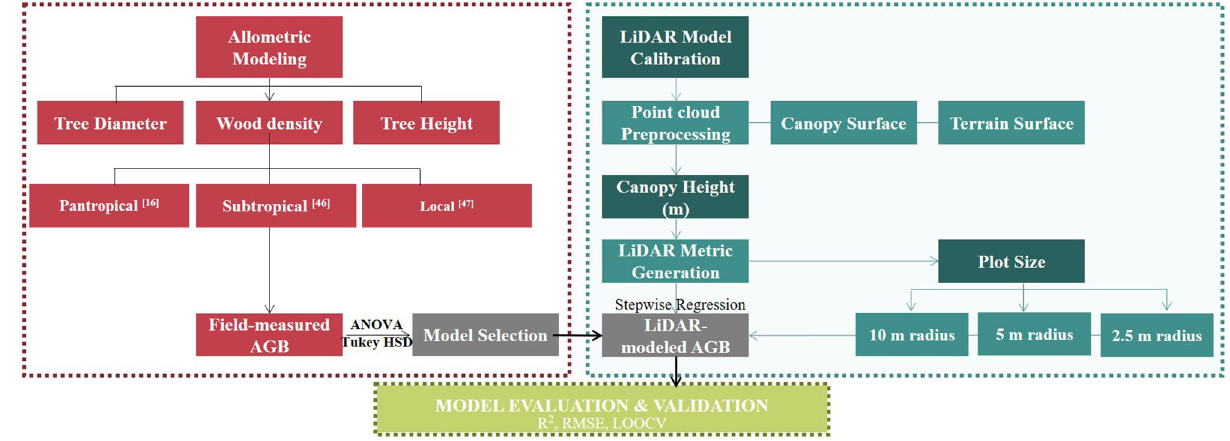
Figure 3. The graphical abstract of the study (Source: